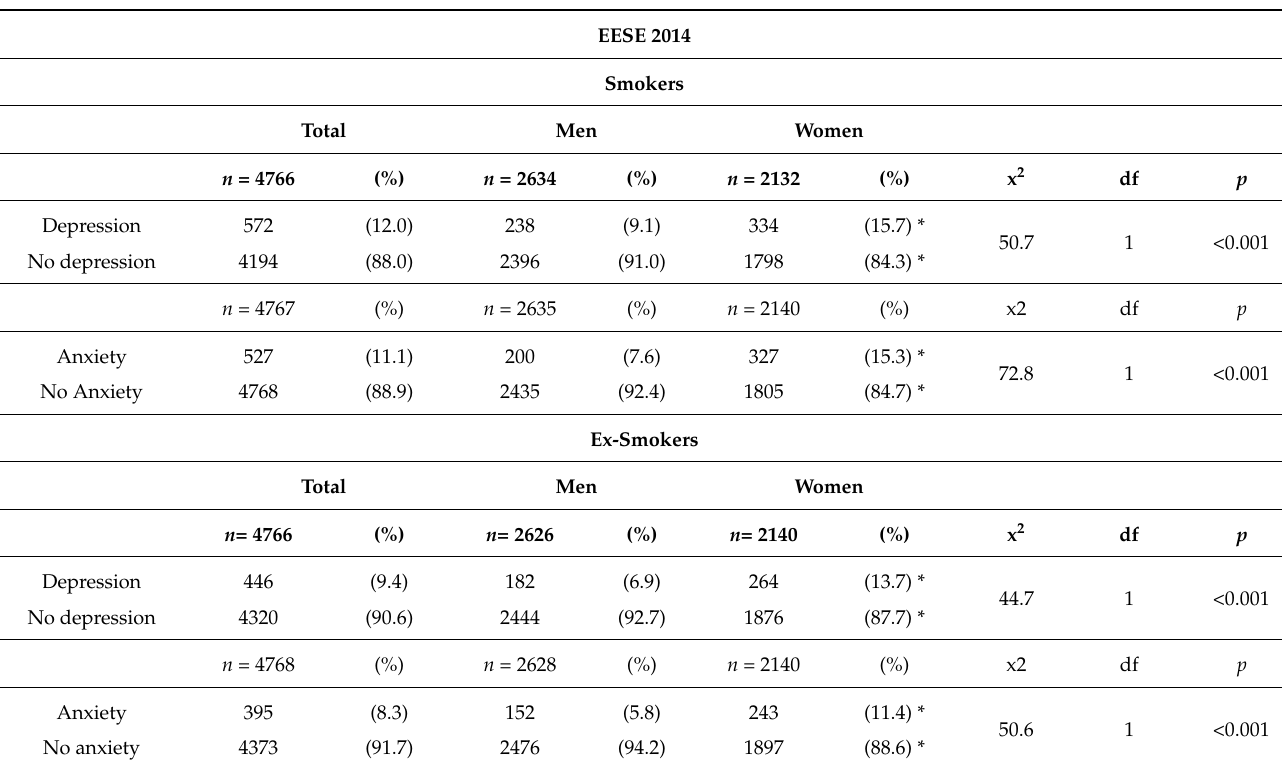
Table A1. Prevalence of depression and anxiety in Spanish smokers and ex-smokers, and comparison by sex: EESE2014 and